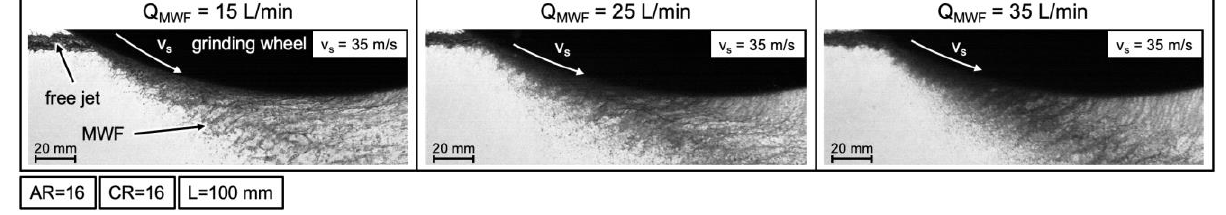
Figure 12. Shadowgraphy records of the interaction area under different flow rates.